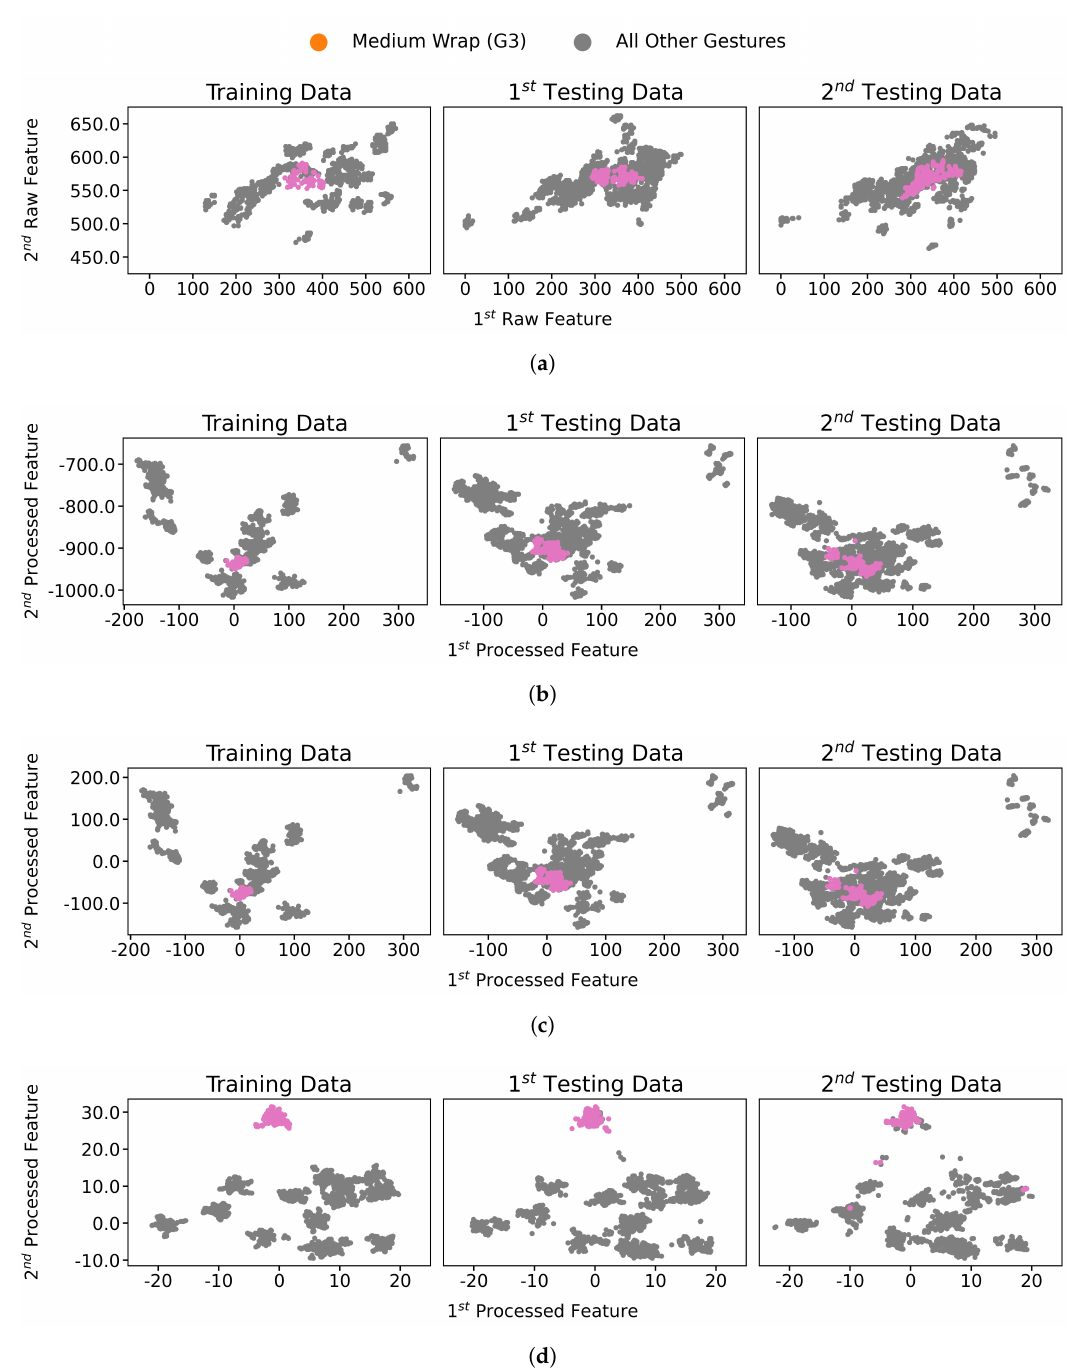
Figure 4. Feature spaces comparison of a single gesture between before- and after- each pipeline processing step, highlighting only medium wrap gesture (G3) of participant 2 training data, using the first two dimensions, the most dominant two, for each feature space. ( a ) Sessions data (G3) using raw features. ( b ) Sessions data (G3) post applying FDA, the first pipeline step. ( c ) Sessions data (G3) post-applying PCA, the second pipeline step. ( d ) Sessions data (G3) post-applying UMAP, the final pipeline